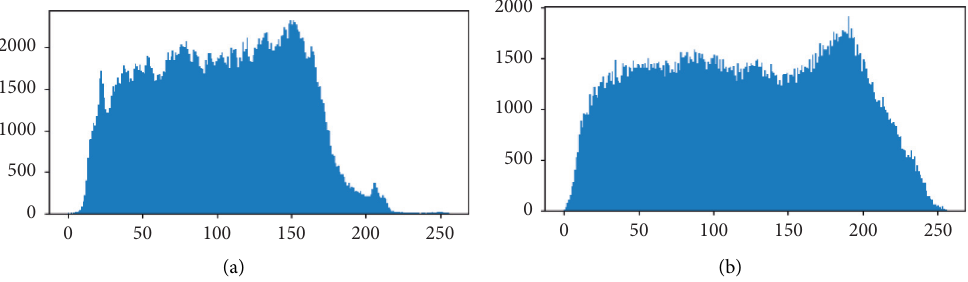
Figure 8: Result of balancing adaptive histogram: (a) original and (b) output